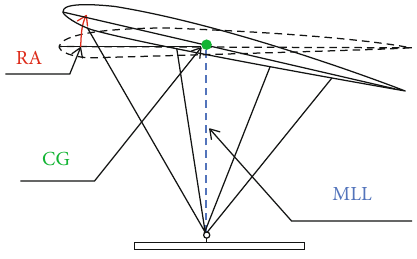
Figure 2: Two-dimensional model of